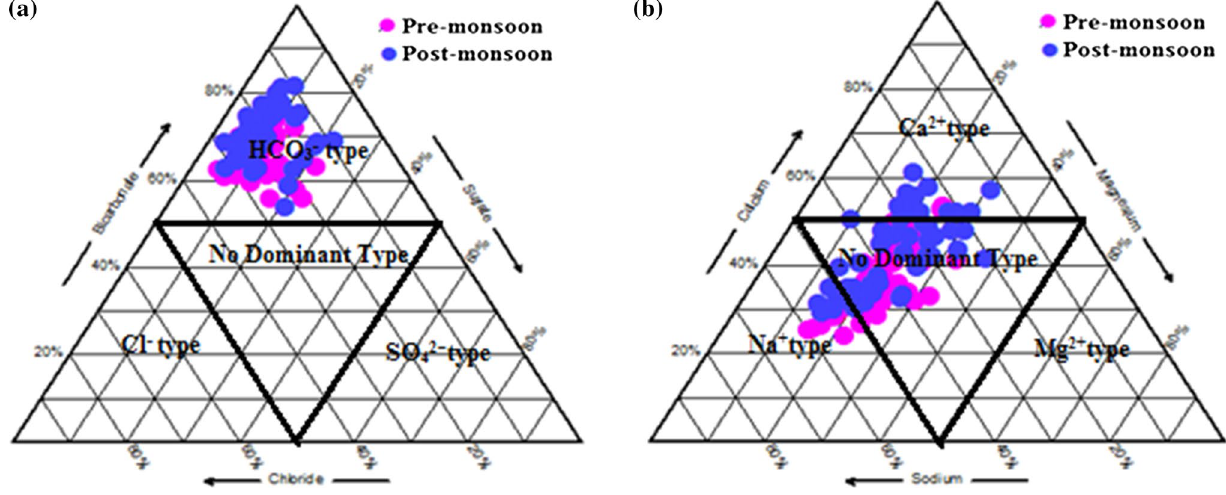
Fig. 6 Ternary anion ( a )–cation ( b ) diagram of the groundwater